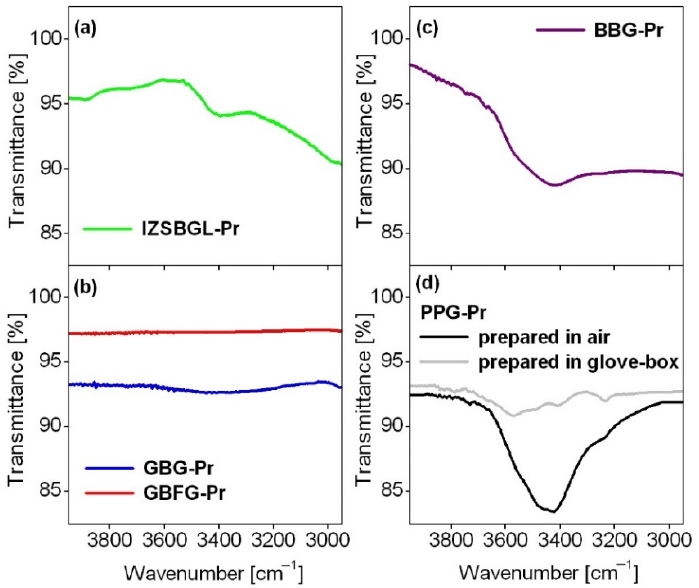
Figure 1. Transmittance spectra measured for the studied glass samples. IZSBGL-Pr ( a ), GBG-Pr and GBFG-Pr ( b ), BBG-Pr ( c ) and PPG-Pr ( d ).